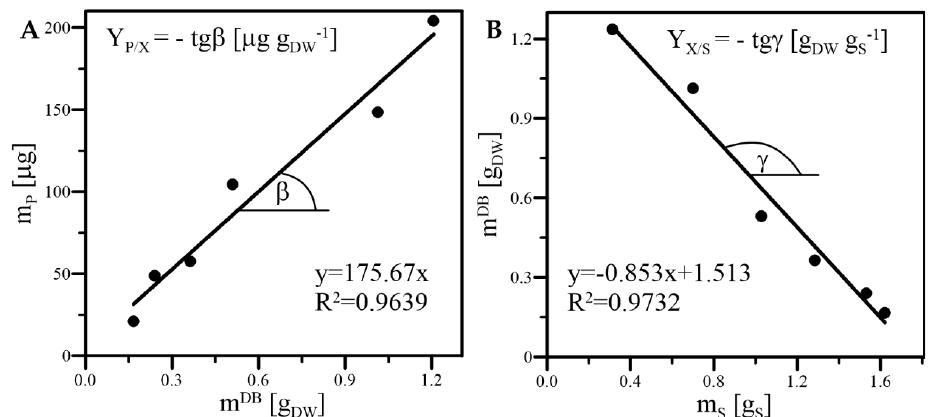
Figure 13. Exemplary determination of Y P/X ( A ) and Y X/S ( B ) values by the graphical methods based on quantitative data collected for the culture of R. graeca hairy roots supported with A1 form of MTMS-based xerogel.